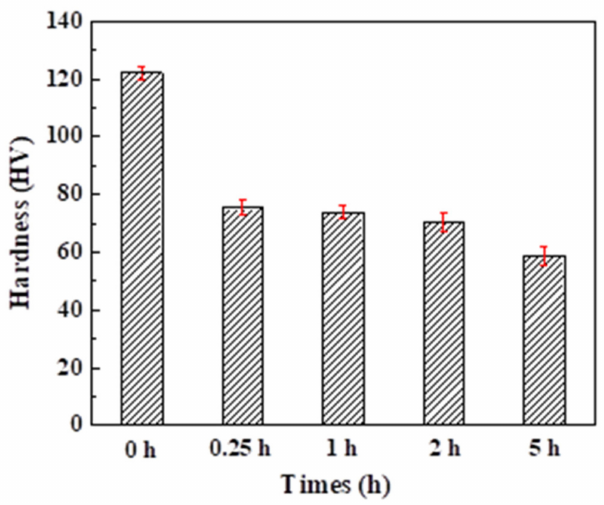
Figure 5. The Vickers hardness of the AlSi10Mg sample fabricated by SLM and the heat- treated samples.